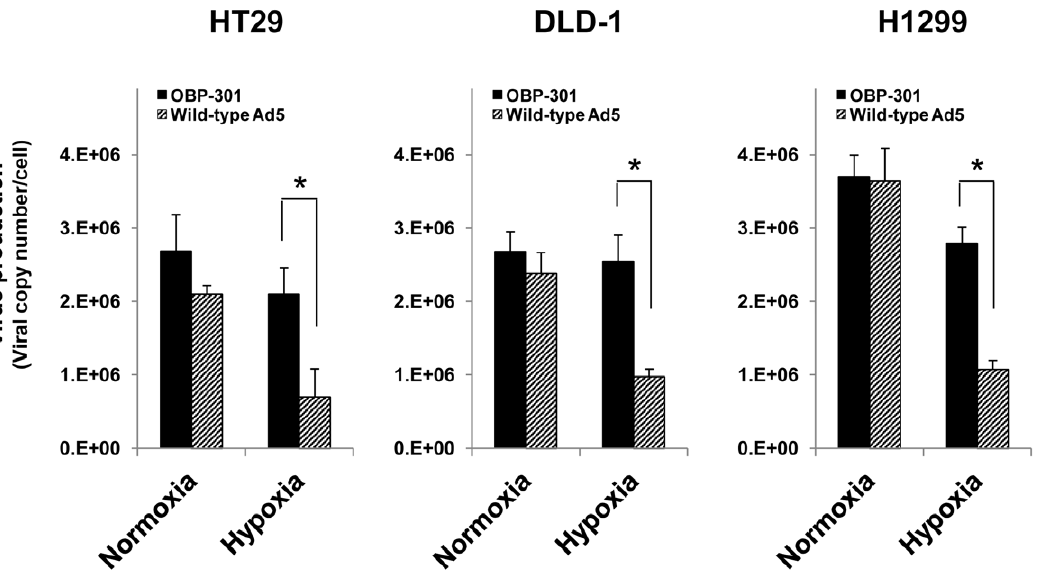
Figure 4. Quantification of viral DNA replication in human cancer cells under normoxia or hypoxia. The indicated human cancer cells were infected with OBP-301 or Ad5 at an MOI of 50 PFU/cell for 1 h, and were further incubated under normoxic (Nx) or hypoxic (Hx) conditions for 48 h. After incubation, cells were harvested and counted. E1A copy number in the cells at 48 h after incubation under normoxia or hypoxia was analyzed by quantitative PCR analysis. The amount of virus production was defined as the value of the E1A copy number relative to the number of cancer cells. Data are shown as the mean values 6 SE of triplicate experiments. Statistical significance (*) was determined as P , 0.05 (Student’s t test). doi:10.1371/journal.pone.0039292.g004 PLoS ONE |